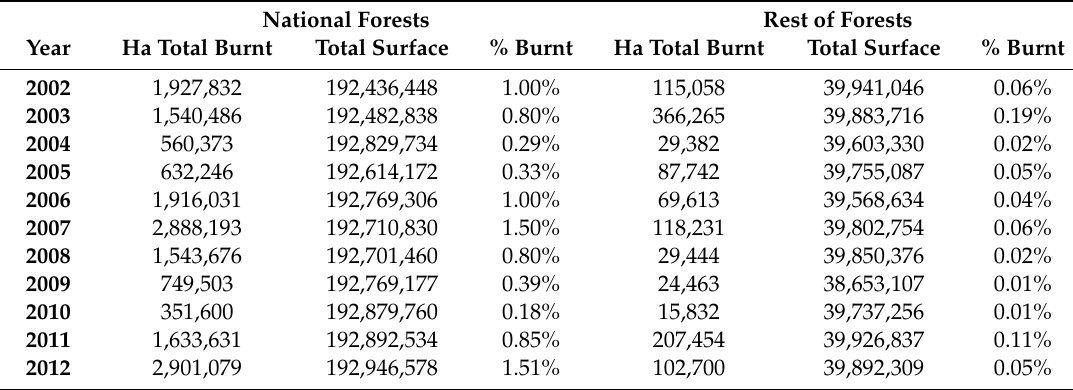
Table 8. Burnt surface and total forest surface of National Forests and the rest of forests. Source: USFS. National Forests Rest of